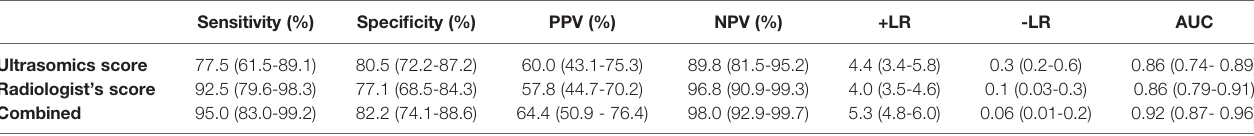
TABLE 3 | Validation in the sub-group of HCC with normal AFP value. Sensitivity